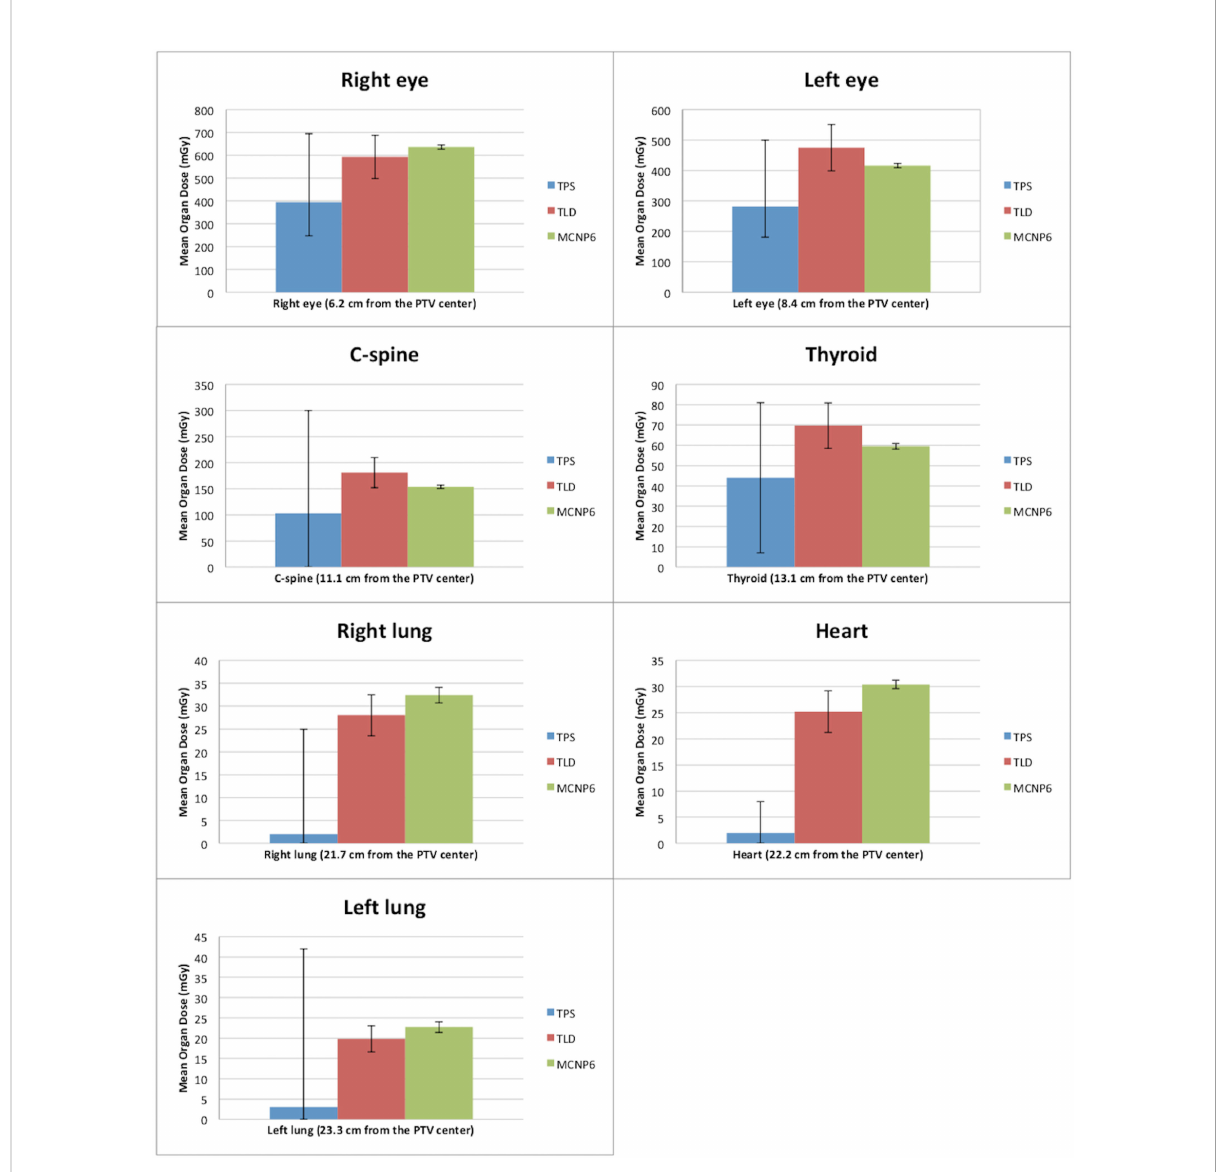
FIGURE 2 Comparison between doses outside the treatment fi elds obtained by TPS, TLDs, and MC for the 3DCRT technique. The error bars of the TPS dose calculations de fi ne the interval between the minimum and maximum calculated doses. The error bars of the measurements with the TLDs correspond to measurements of standard deviations. The error bars of the MC simulations correspond to the calculated uncertainty for each